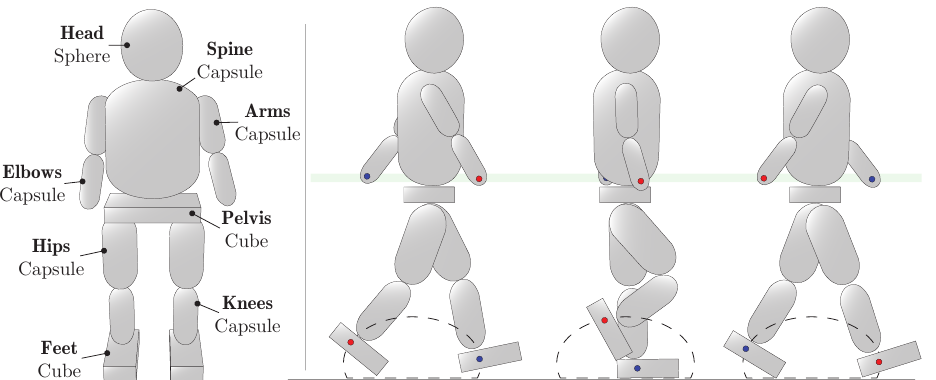
Figure 3. Front view of humanoid model ( left ) and illustration of concept used to perform locomotion by pushing the feet of the humanoid around in elliptical orbits ( right